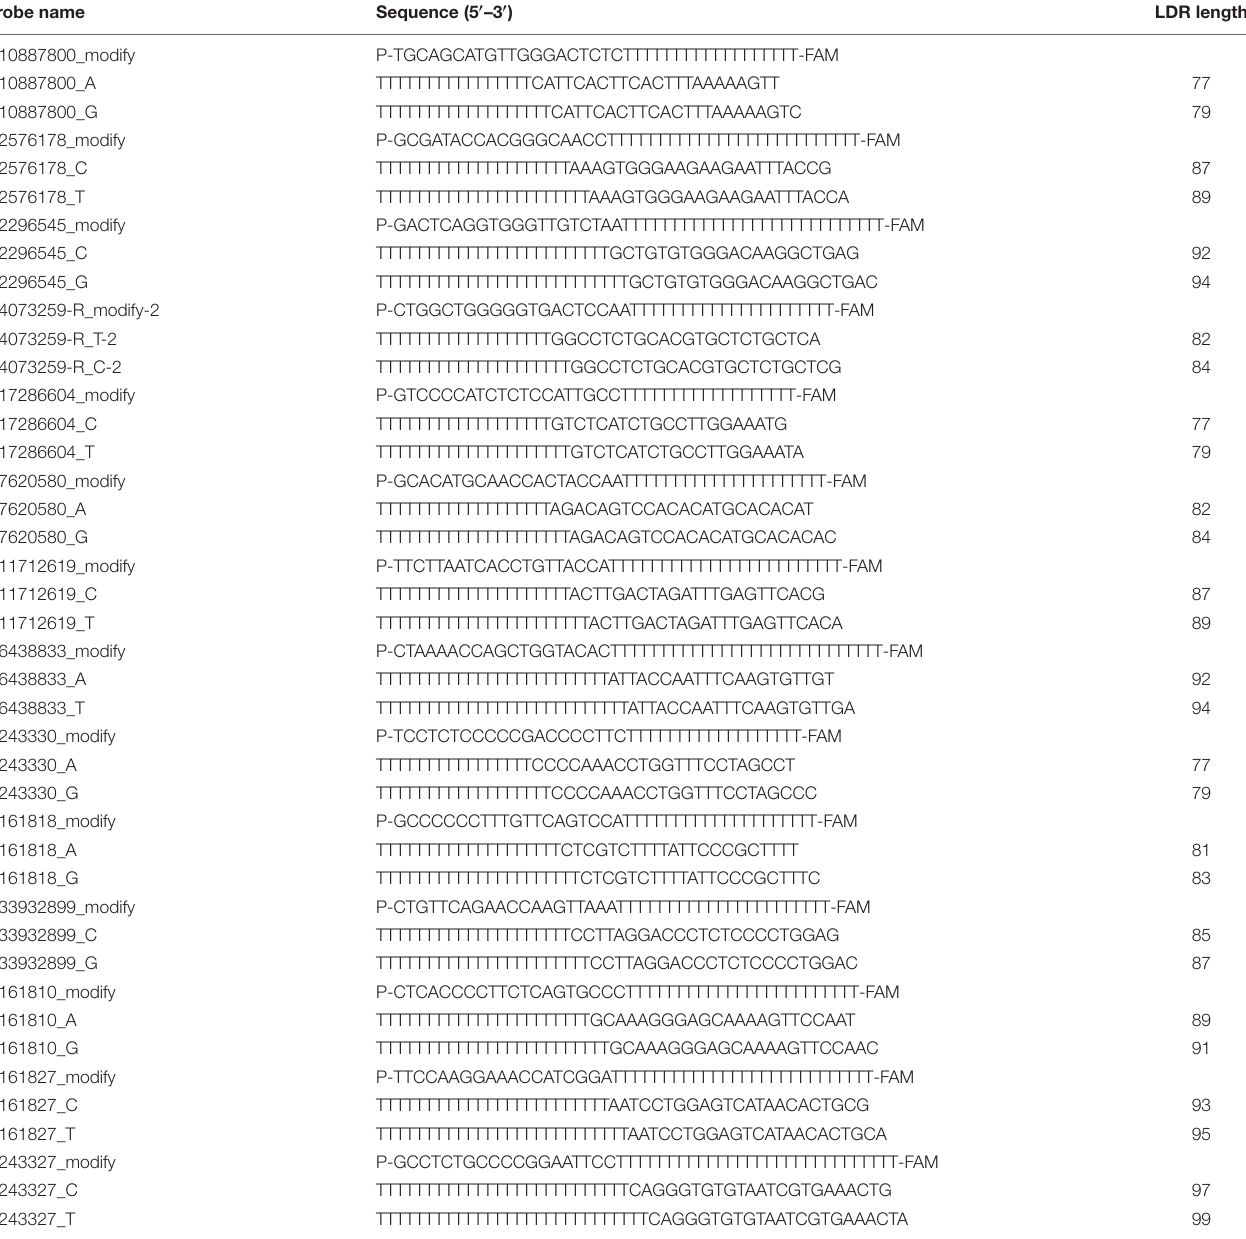
TABLE 2 | LDR target gene probe